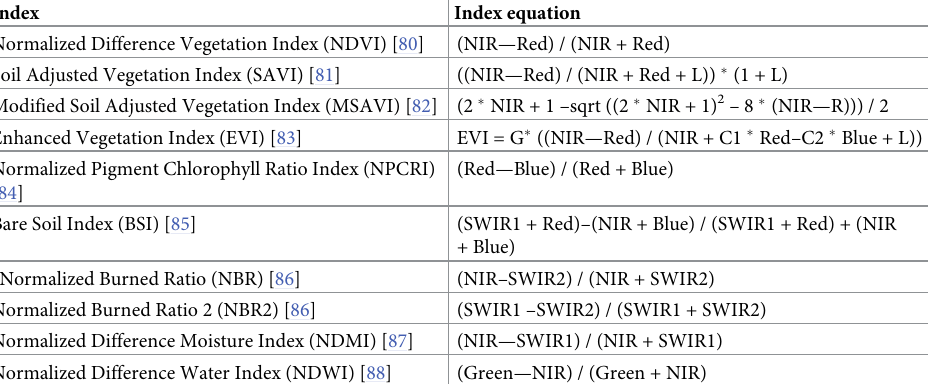
Table 2. Spectral indices with their references and corresponding equations used to explain ecosystem services measured in the field.